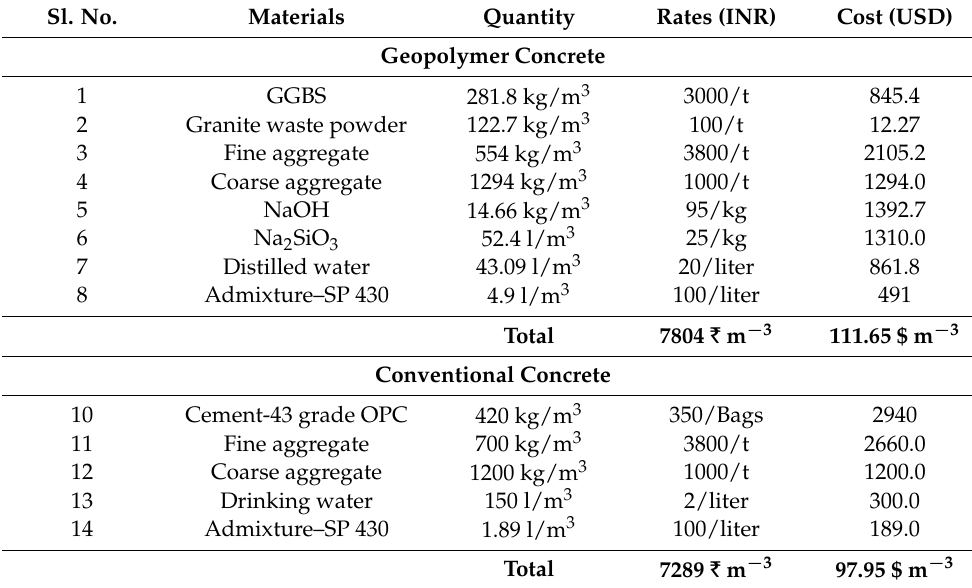
Table 3. Cost analysis of GPC and conventional concrete. Sl.